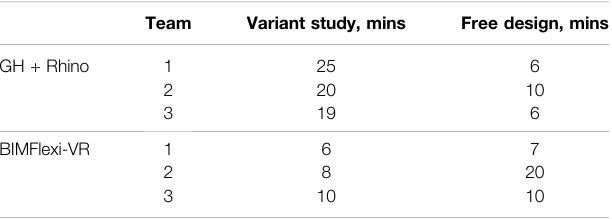
TABLE 2 | Task completion times. Abbreviations: GH =